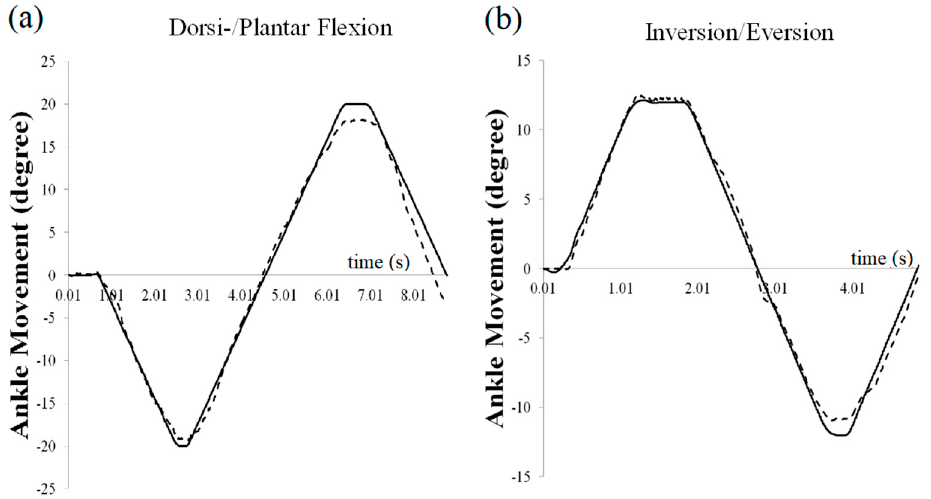
Figure 2. Comparison between AMT measurements and motion capture system (Vicon Motion Systems Ltd., Oxford, UK): ( a ) One cycle of dorsi-/plantar flexion movement (average r = 0.996, 0.983 < r < 0.999), ( b ) one cycle of inversion/eversion movements (average r =0.985, 0.959 < r < 0.999) .